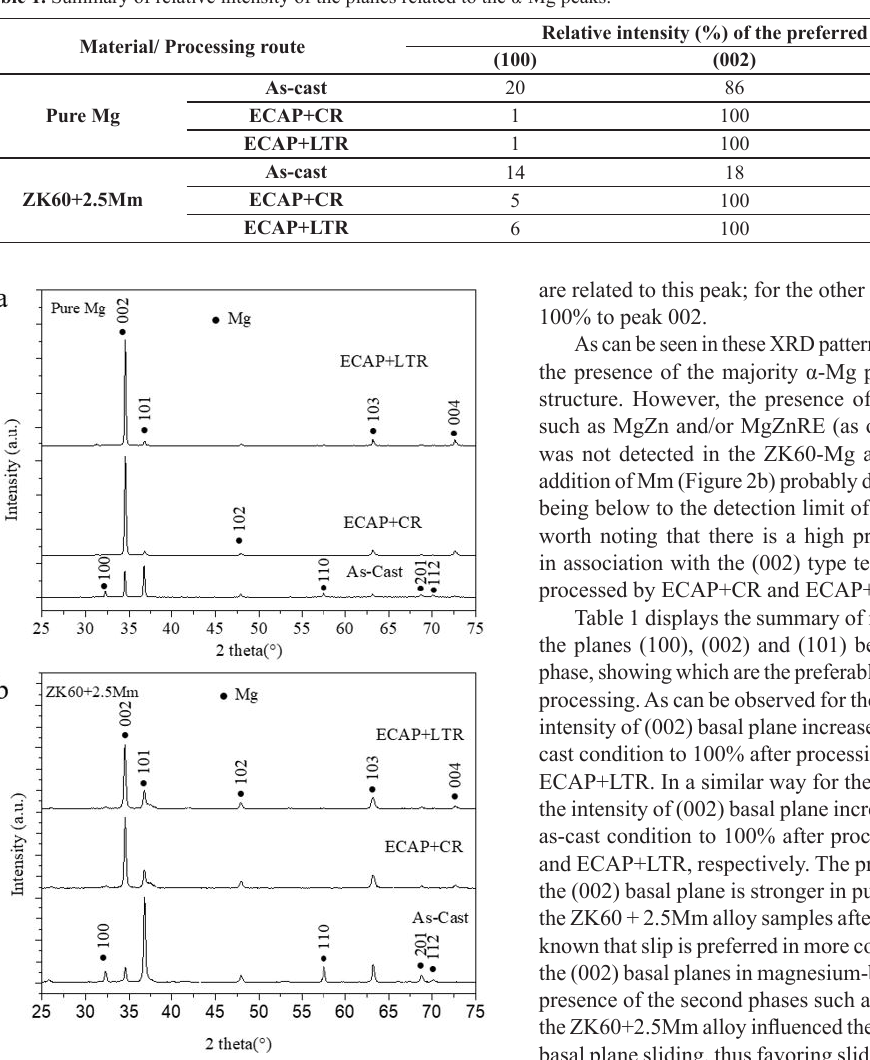
Figure 2. XRD patterns of pure Mg ( a ) and ZK60+2.5Mm ( b ) alloy in the AC, ECAP+CR and ECAP+LTR states.